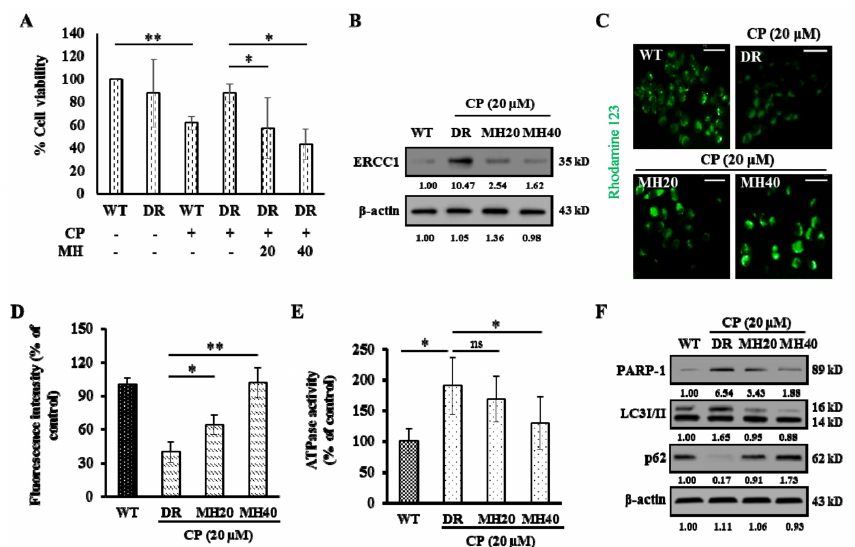
Figure 1. Morin hydrate (MH) reverses cisplatin (CP) resistance of HepG2 DR cells. ( A ) Cell viability of HepG2 WT and HepG2 DR cells was measured after CP and CP-MH treatment by the MTT assay. ( B ) Western blot analysis of excision repair cross-complementation group 1 (ERCC1) expression in HepG2 DR cells as a marker of developing CP resistance; ERCC1 levels were normalized to those of β -actin. ( C ) Fluorescent micrograph of rhodamine-123 intracellular accumulation in HepG2 DR cells using an ATP-binding cassette sub-family B member 1 (ABCB1 or P-gp) activity assay after 24 h of corresponding drug treatment (magnification: 200 × ; scale bar: 0.1 mm). ( D ) Fluorescence intensity calculated using the ImageJ software. ( E ) ATPase activity of HepG2 DR cells after 24 h of CP-MH treatment. ( F ) Expression levels of poly(ADP-ribose) polymerase 1 (PARP1), LC3I / II, and p62 in HepG2 DR cells were analyzed by Western blotting; results were normalized relative to β -actin. Relative intensities were measured by ImageJ software. Data are presented as the means ± standard deviation (SD) ( n = 3). * p < 0.05, ** p < 0.01. DR = drug resistant; WT = wild